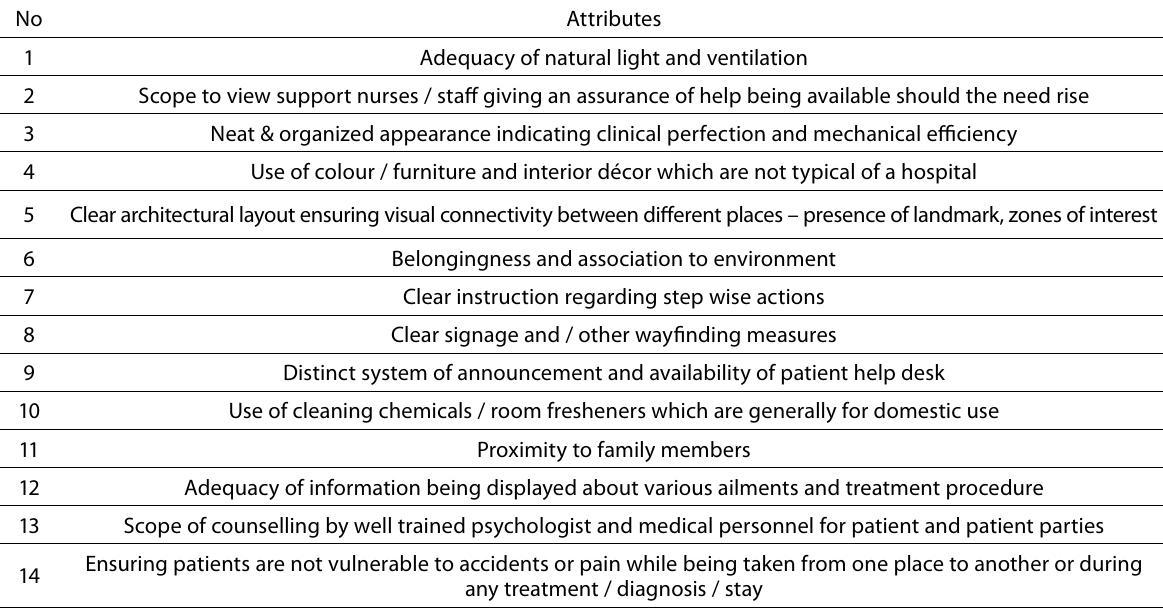
Table 2. Environmental attributes associated with psychological